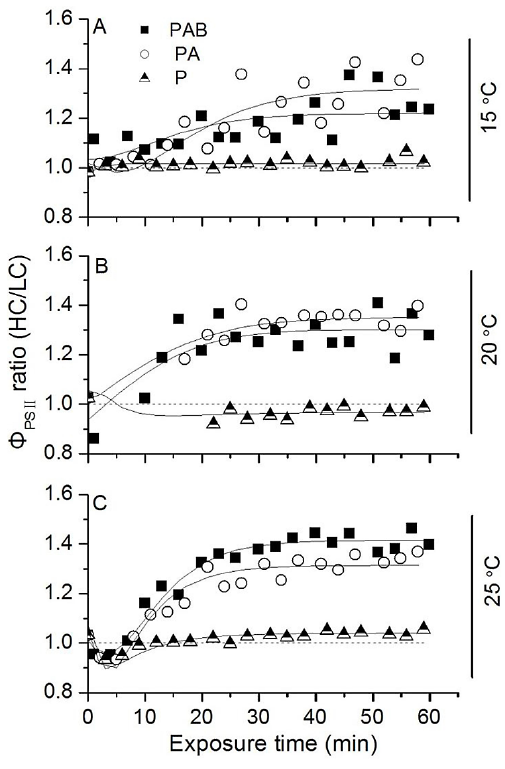
Fig. 2. Ratio of the HC- to LC-grown cells’ effective quantum yield ( 8 PSII ) in P. tricornutum exposed to the three radiation treatments – PAB (irradiated above 295 nm, black squares), PA (irradiances above 320nm, white circles) and P (irradiances above 395nm, half solid triangles) – at 15, 20 and 25 ◦ C. Solid lines represent the best fit while the broken lines represent the value of